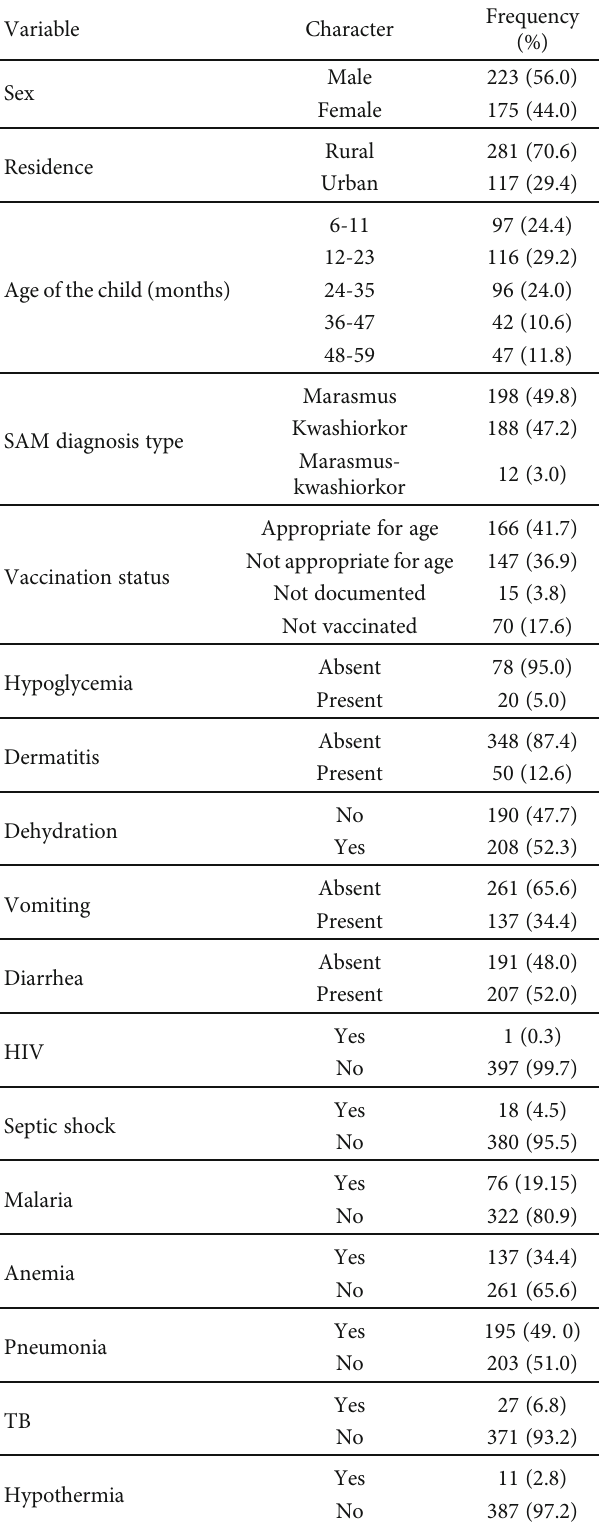
Table 2: Sociodemographic and baseline characteristics of 6 – 59- month-old children with severe acute malnutrition in the therapeutic feeding center at Pawi General Hospital, northwest Ethiopia (2013-2017) ( n = 398 ).